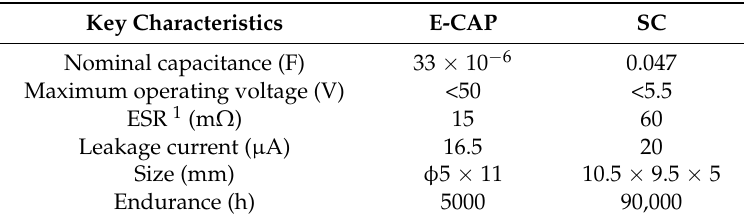
Table 2. Basic Information about the electrolytic capacitor (E-CAP) and super capacitor (SC). Key